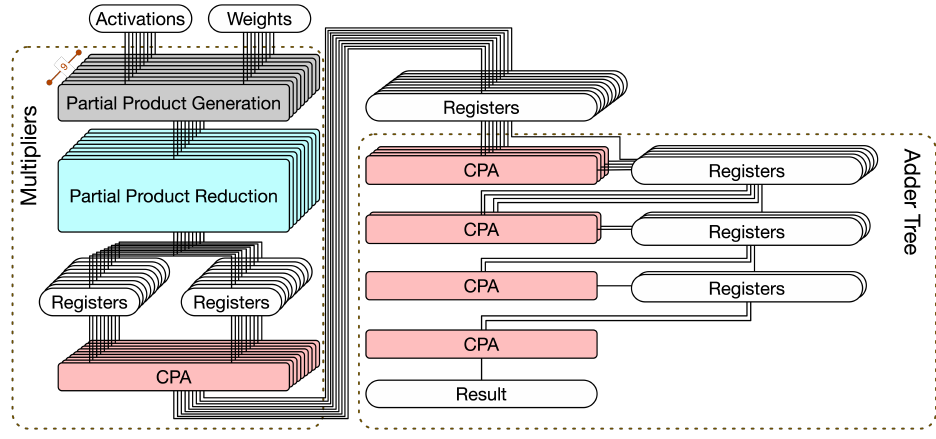
Figure 3. The straightforward hardware circuit implementation for the 3 × 3